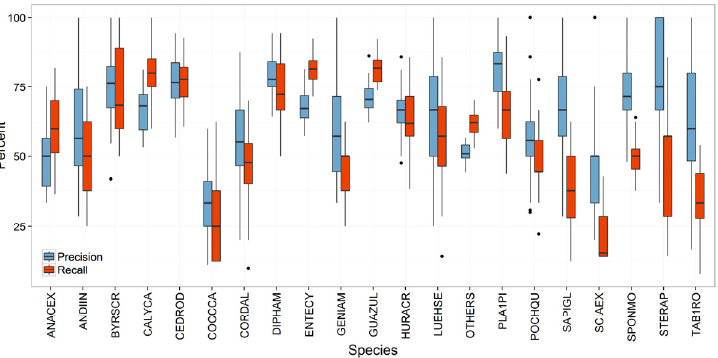
Figure 4. Species-level recall and precision percent accuracy across 30 model iterations. Full species